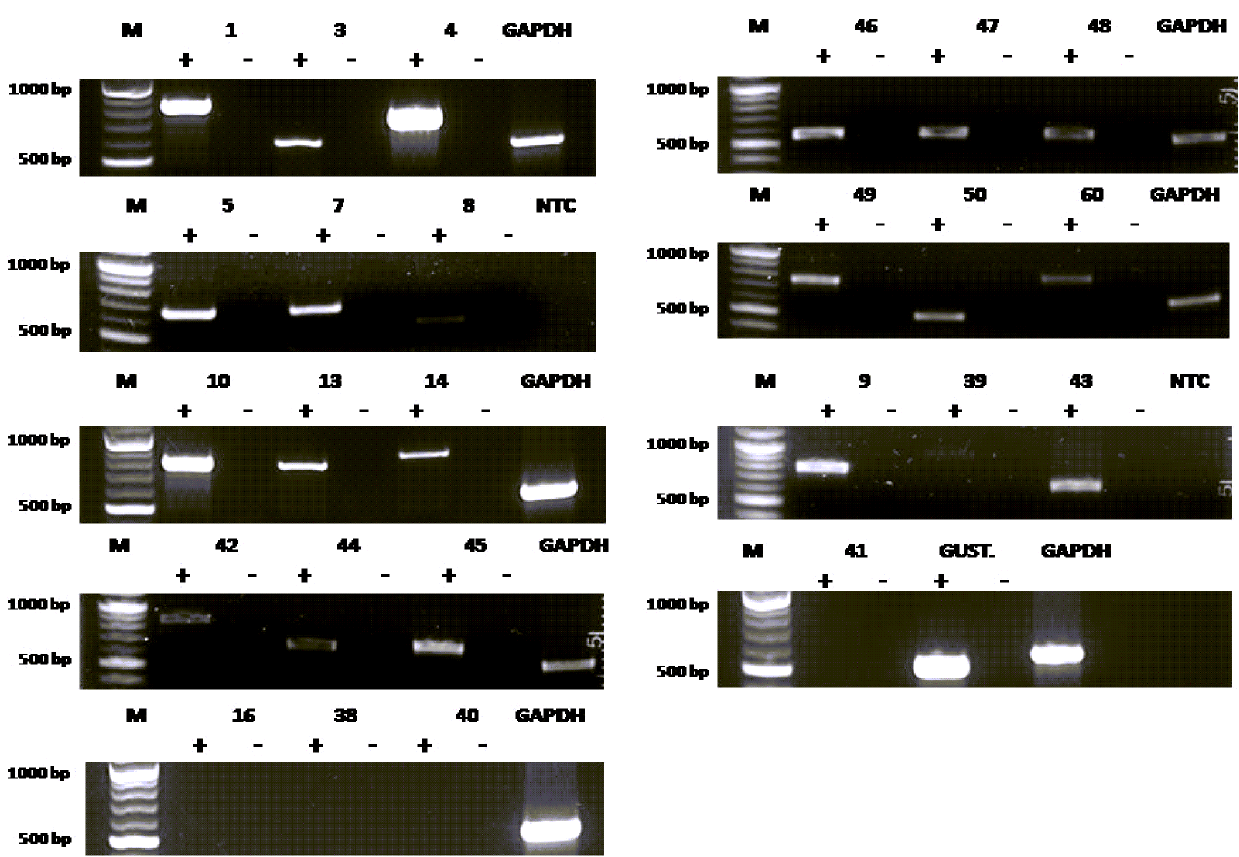
Figure 1. Reverse transcriptase (RT)-PCR analysis of the expression of bitter taste receptors (TAS2Rs) in hPASMCs. Agarose gel electrophoresis (1%) analysis of the RT-PCR products showed that 21 T2Rs were expressed in hPASMCs. GAPDH was used as an internal control for the PCR reactions. + and – represent the addition and omittance of reverse transcriptase in the reaction respectively. NTC represents a no template control in which the cDNA template was omitted. M represents 100 bp molecular weight standard (NEB). All transcripts were observed at the expected amplicon size. Each agarose gel electrophoresis is representative of 4–5 independent experiments.